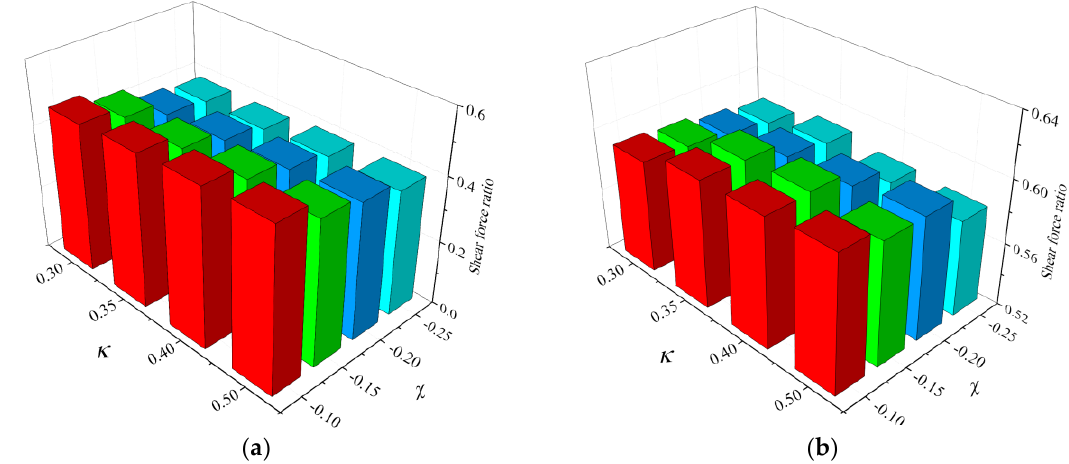
Figure 13. Ratios of shear forces between NSAS-based isolation system and CIS: ( a ) β SF , NSAS / β SF , CIS ; ( b ) γ SF , NSAS / γ SF , CIS . Table 4. Values of β SF , NSAS / β SF , CIS